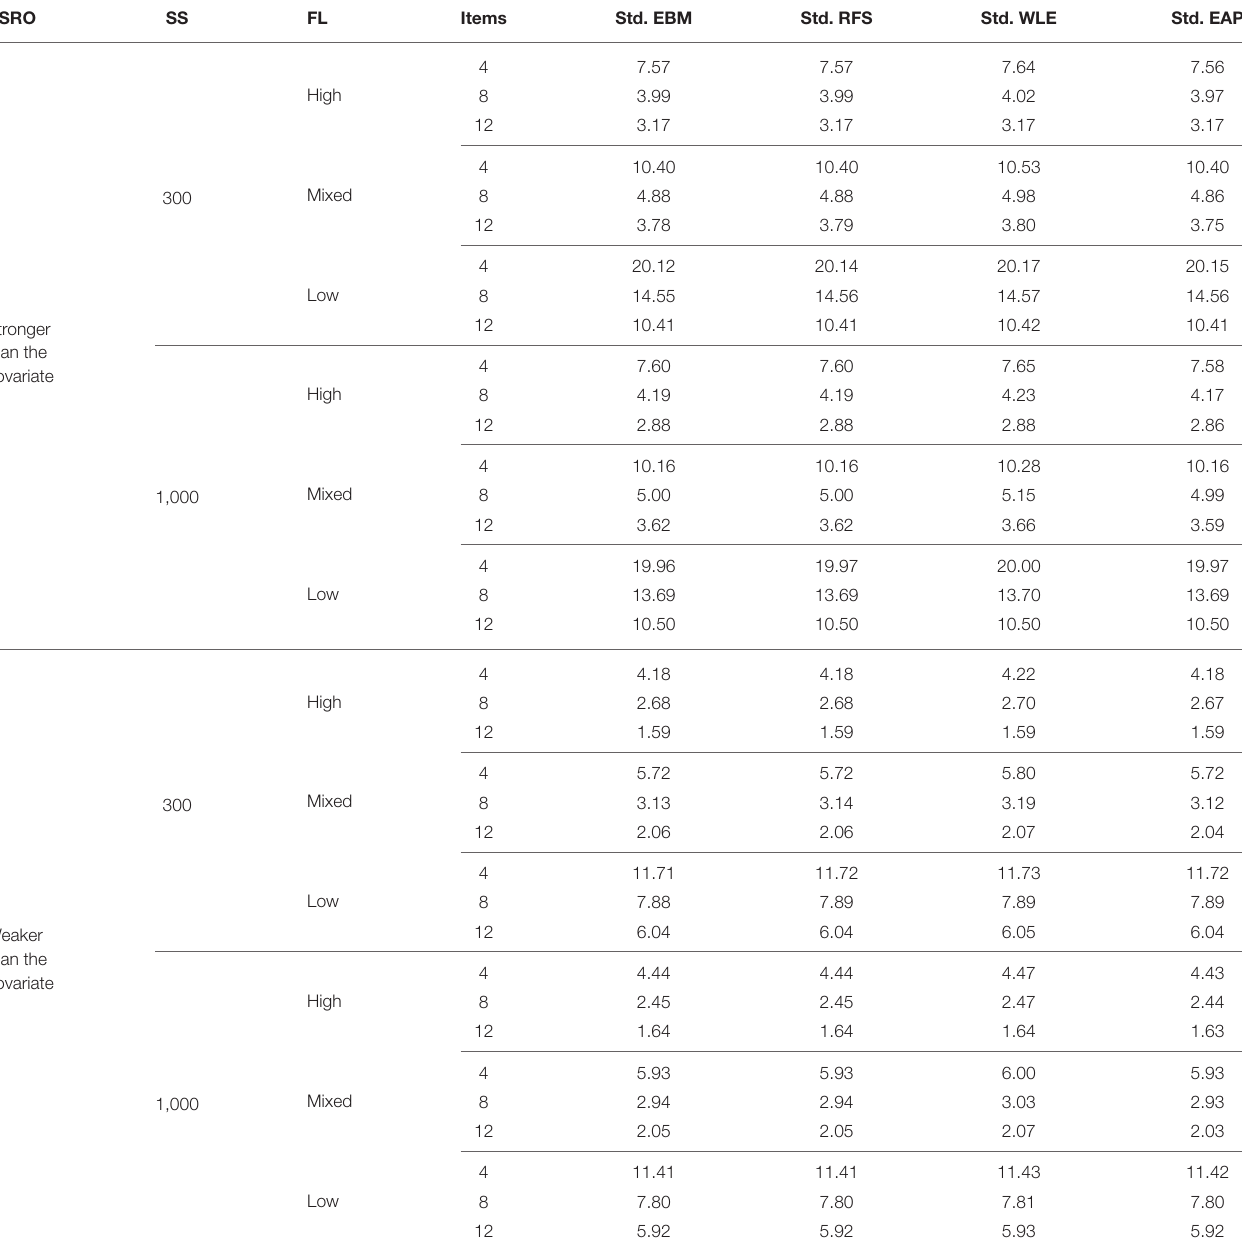
TABLE A2 | Mean percentage bias of regression coefficient of the covariate for standardized test scores apart from SMS. RSRO SS FL Items Std. EBM Std. RFS Std. WLE Std. EAP